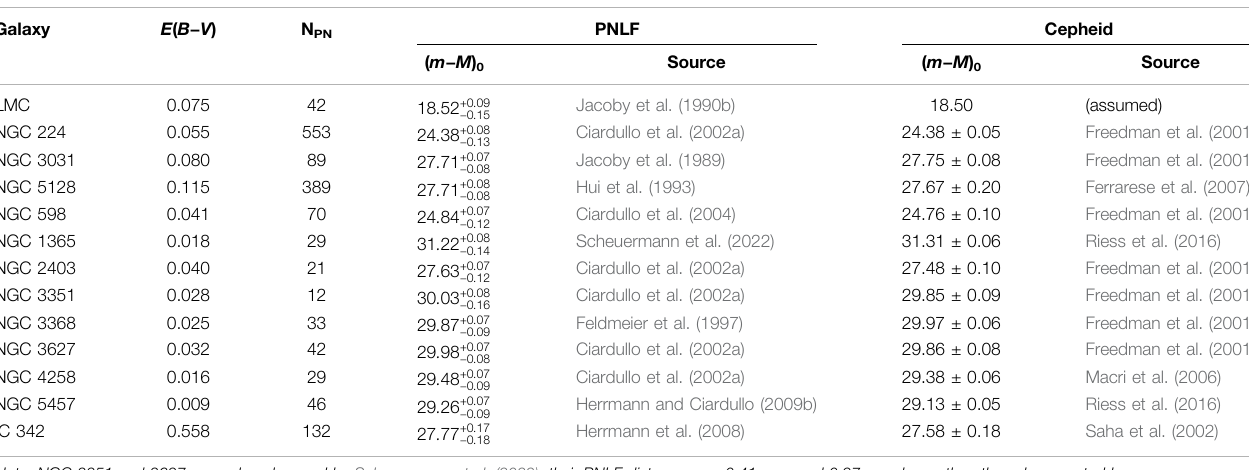
TABLE 1 | Galaxies with Cepheid distances.